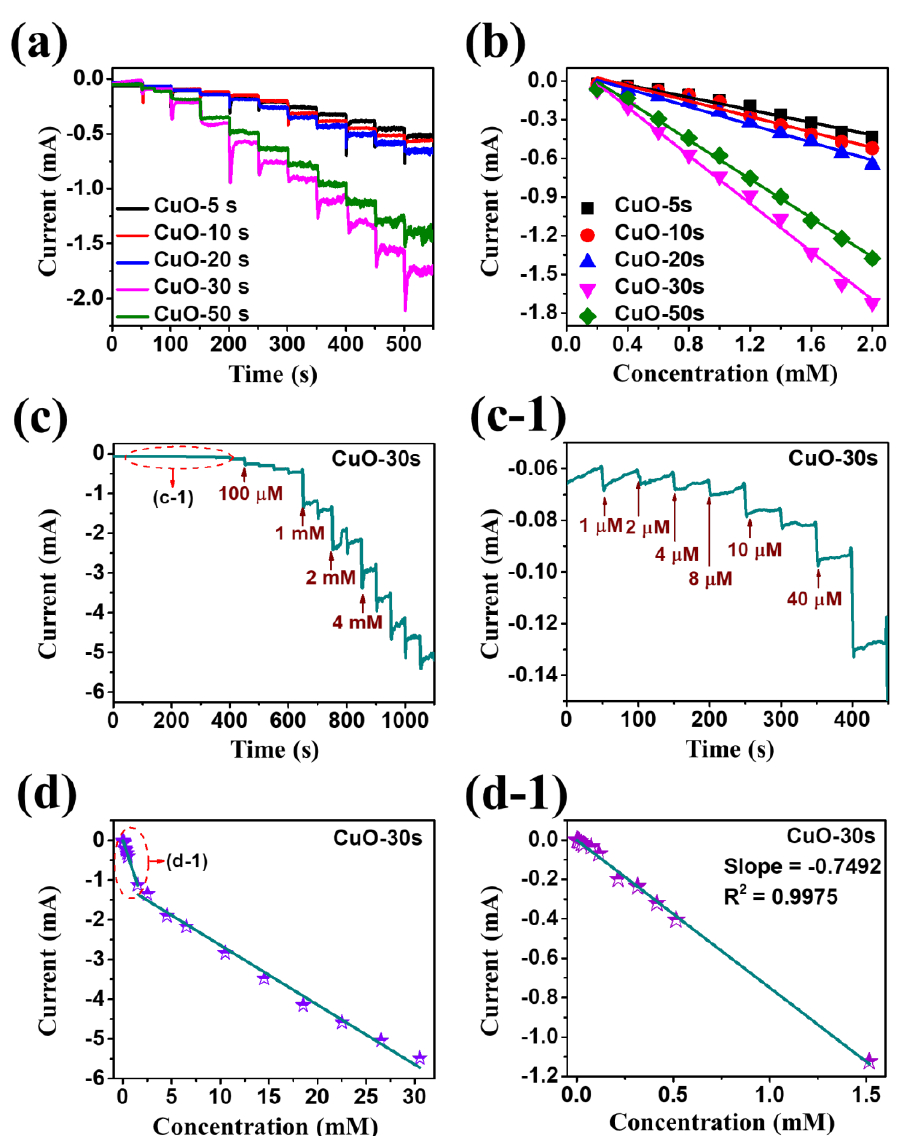
Figure 4. ( a ) Steady-state current time response of porous CuO/Pt hybrid detectors fabricated at a di ff erent duration between 5 and 50 s upon the successive addition of 0.2 mM H 2 O 2 in N 2 - saturated 0.1 M PBS (pH 7.4) at an applied potential of − 0.4 V. ( b ) Corresponding calibration curves of various CuO samples for H 2 O 2 detection. ( c , c-1 ) Amperometric response of CuO-30 s to dropwise addition of H 2 O 2 from low (1 µ M) to high (4 mM) concentrations. ( d , d-1 ) Linear calibration curve of CuO-30 s based on the current versus H 2 O 2 concentration at high concentration range from 0.1–4 mM and low concentration range from 1 µM–1.5 mM.